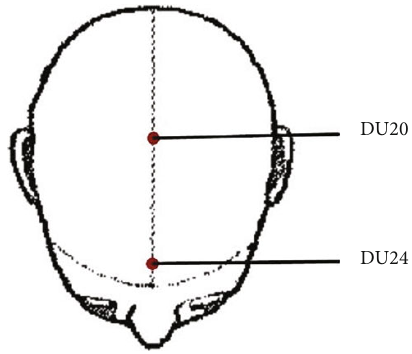
Figure 3: DU 20 (Bai Hui) and DU24 (Shen